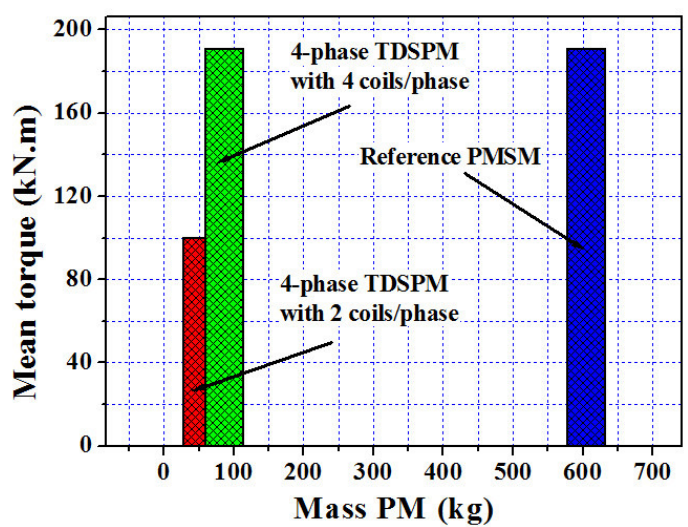
Figure 12. PM-mass